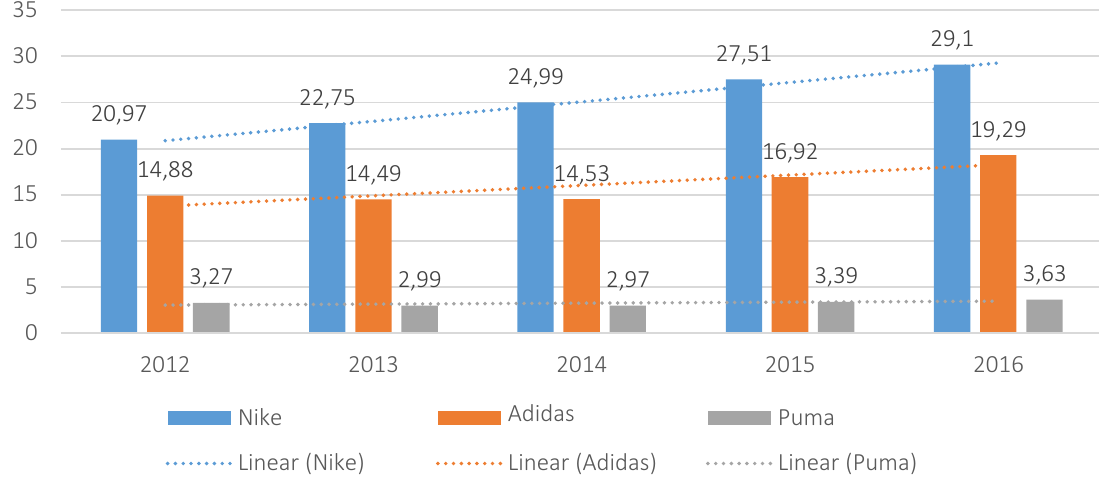
Figure 1. Global incomes of Nike, Adidas and Puma, 2011–2016, in billions of euros